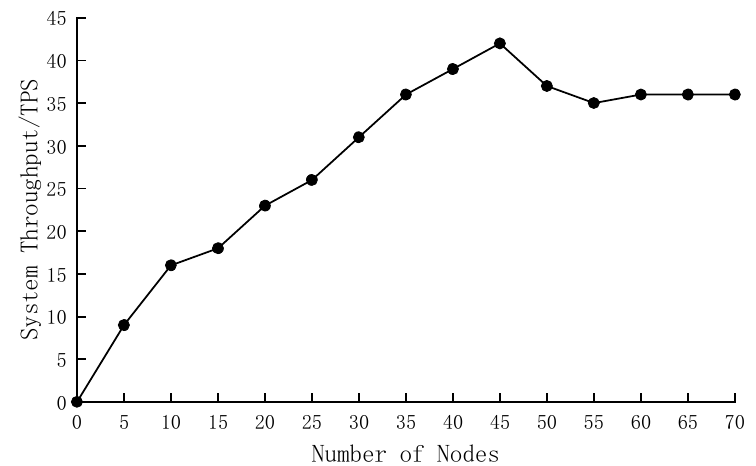
Figure 16. System throughput under different number of nodes.